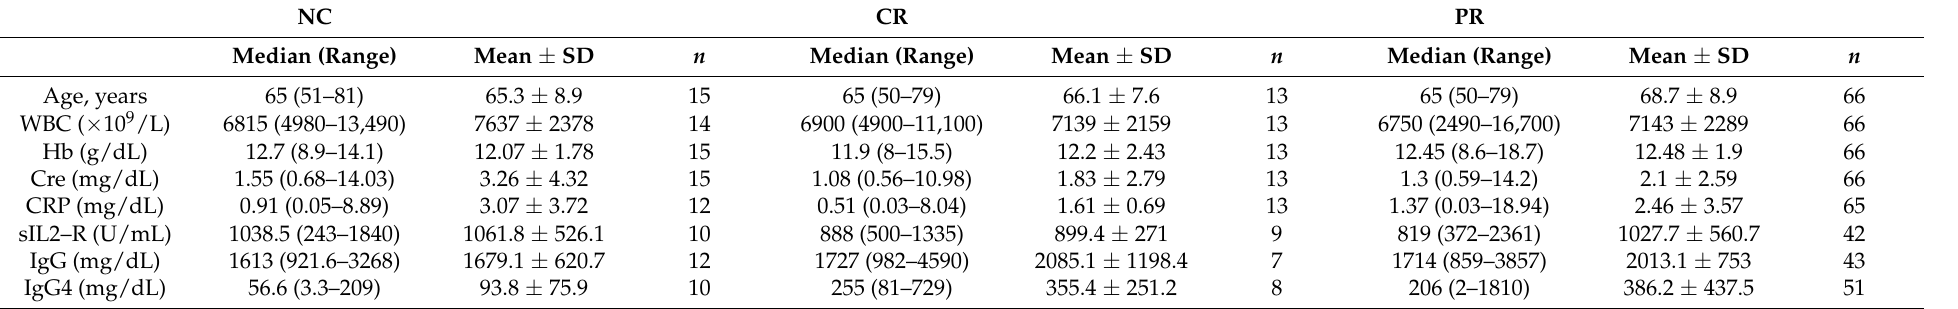
Table 2. Laboratory data in each group classified by response to glucocorticoid